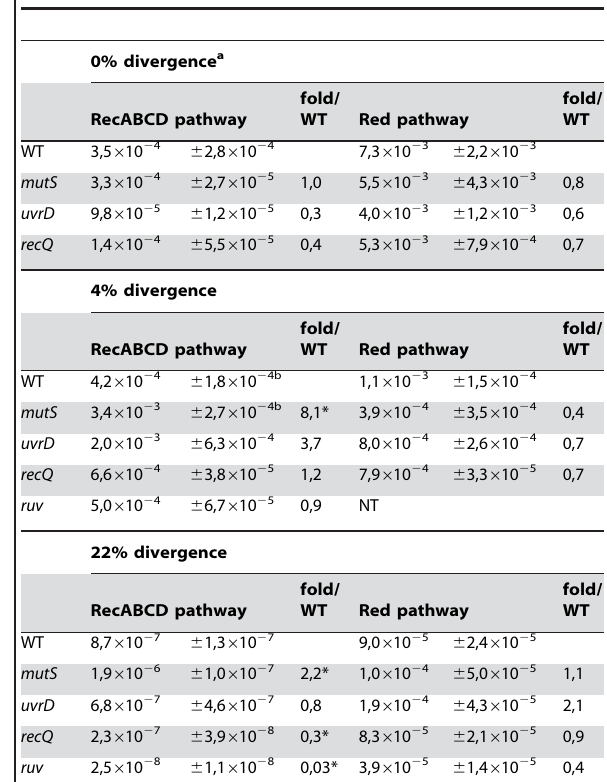
Table 1. Recombinant frequency between 0%, 4% and 22% diverged sequences present in l , in the RecABCD and the Red